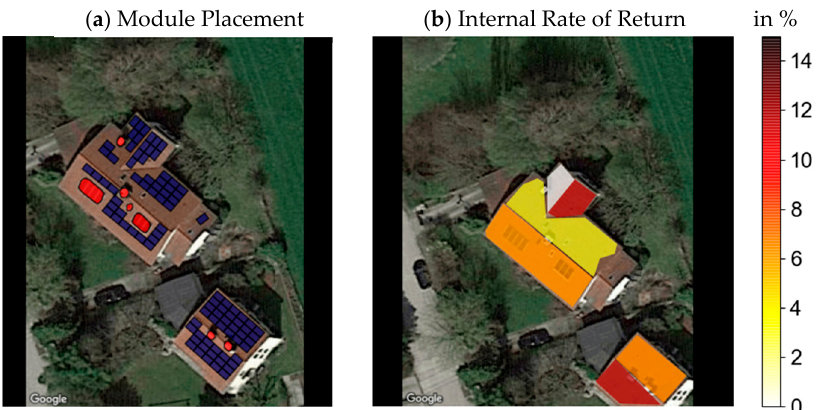
Figure 7. Image ( a ) detected superstructures and module placement and ( b ) resulting economic potential calculated as IRR for each segment.